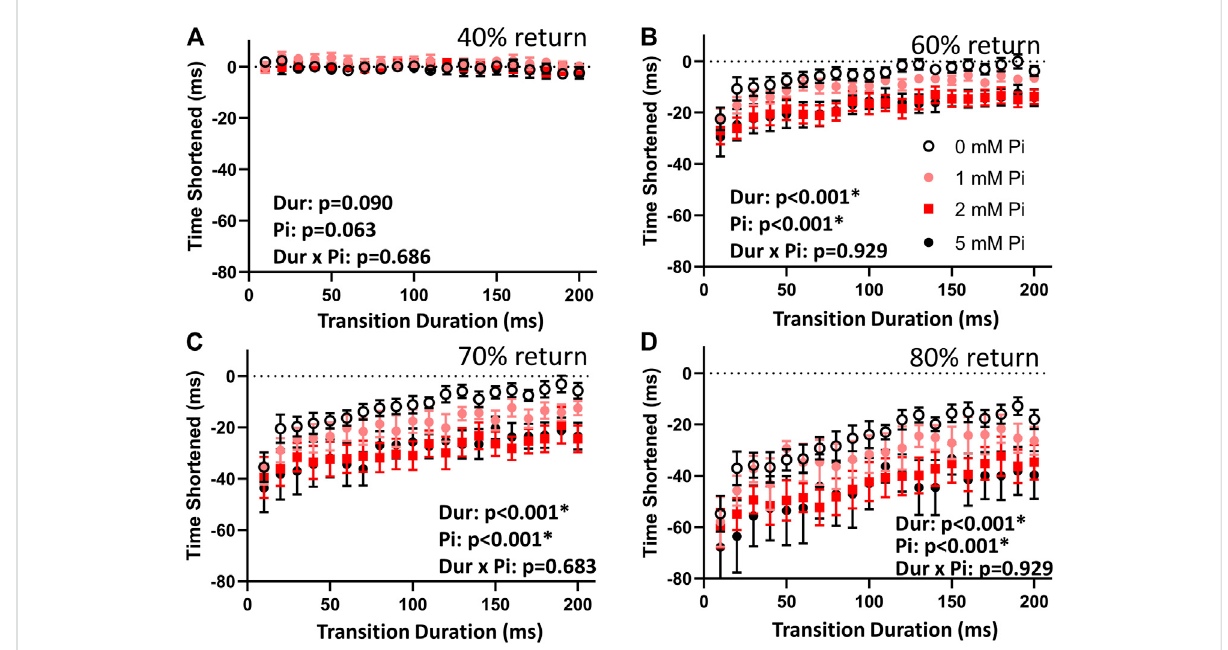
FIGURE 4 Effects of stretch on times to return. (A) The time to 40% return was not affected by lengthening imposed at time to 50% return. This result indicates that the stimulated transients were repeatable and comparable throughout the lengthening protocol by this measure. (B) When no extracellularPiwasavailable(0 mMPi),thetimeto60%returnwasabbreviatedbythose1%stretchesimposedoverlessthan110 ms.Fasterstretches resulted in shorter times to 60% return, as indicated by the highly signi fi cant duration (Dur) main effect. This abbreviation was ampli fi ed with increasing extracellular Pi as indicated by a highly signi fi cant Pi main effect. (C) With no extracellular Pi, the time to 70% return was abbreviated by stretchesimposedoverlessthan170 ms.Thiseffectwasampli fi edbyextracellularPi. (D) Thetimeto80%returnwasalsoabbreviatedbyallstretches under all conditions but was especially abbreviated by faster stretches and increasing extracellular